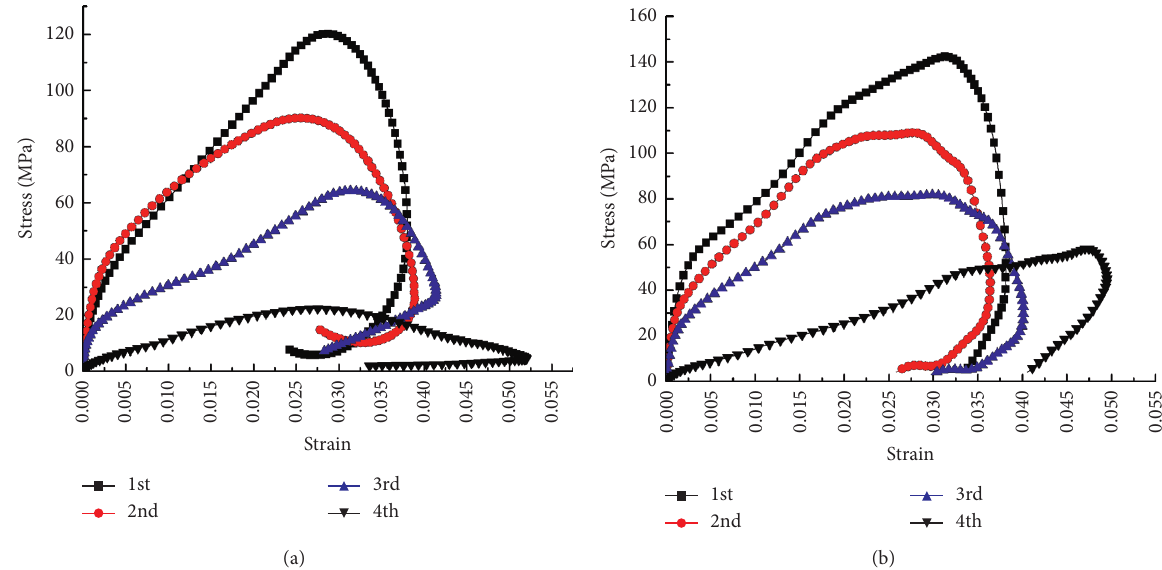
Figure 4: Cyclic impact stress-strain curves of mortar under different air pressures. (a) CC-1 (air pressure of 0.26MPa); (b) CC-2 (air pressure of 0.28 MPa).